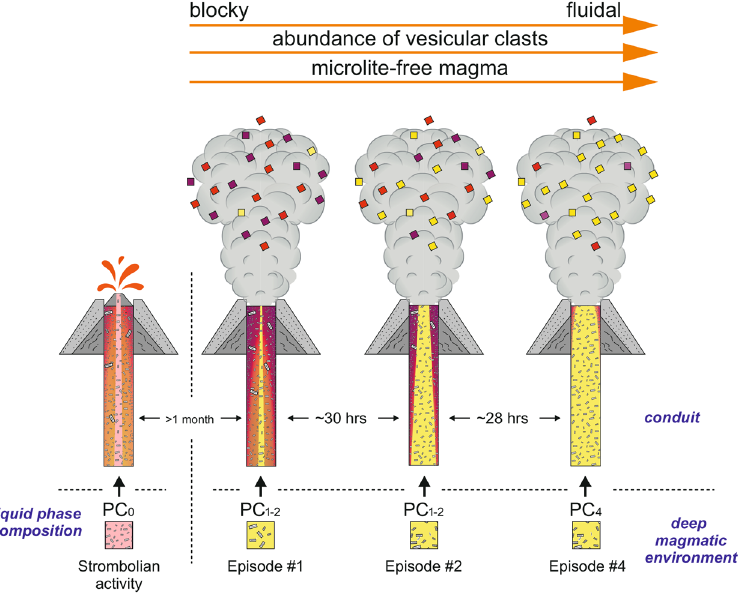
Figure 8. Interpretative model of magmatic and volcanic processes responsible for the four eruptive episodes in December